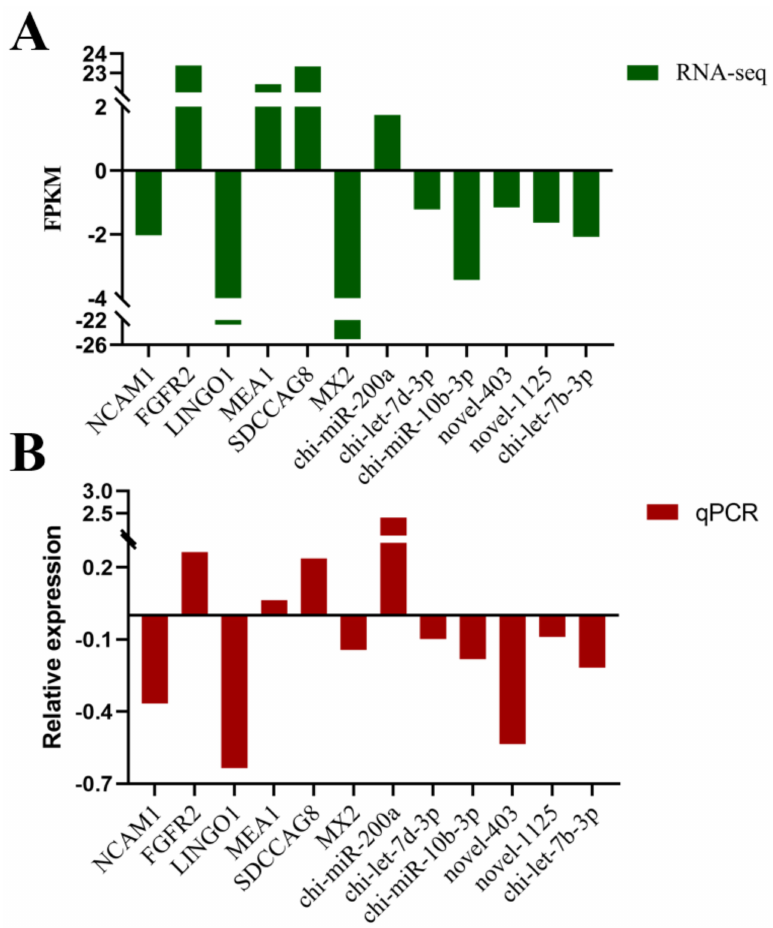
Figure 8. RT-qPCR validation of the mRNAs and miRNAs ( B ) identified by the RNA-seq( A ) in the LP-HF vs